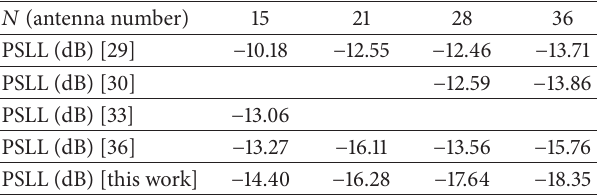
Table 2: Peak sidelobe levels for square arrays of 6 × 6 and 8 × 8 .